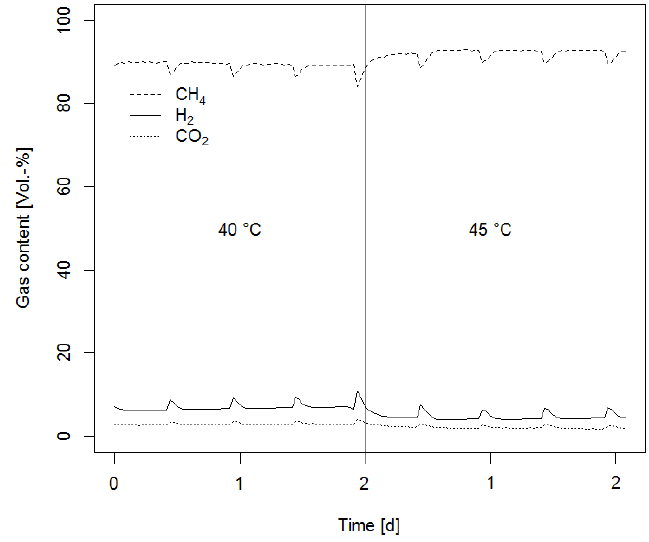
Figure 3. The influence of different temperatures (40 °C and 45 °C) on product gas quality over a period of two days.